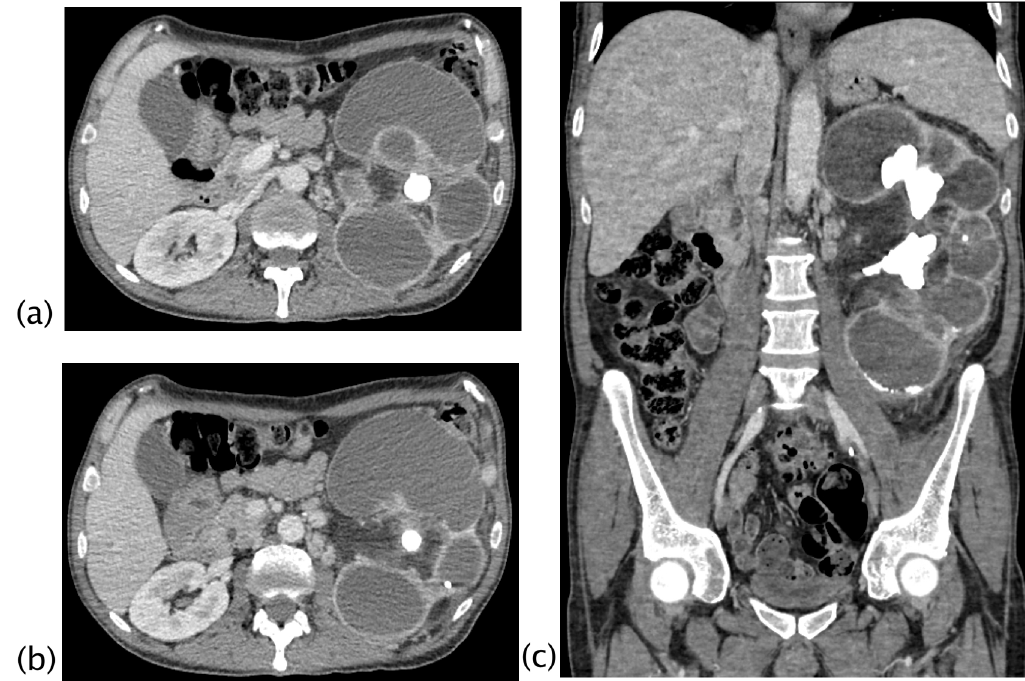
Figure 3. Xanthogranulomatous pyelonephritis Stage I—nephritic form. CT with contrast agent: axial ( a , b ) and coronal MPR reconstruction ( c ). The left kidney is increased in volume with a characteristic “contracted” appearance of the renal pelvis. The renal parenchyma is extremely thinned and characterized by the presence of multiple hypodense areas representing both intraparenchymal collections of pus and dilated calyces. The wall of the pyelocaliceal structures is thickened and hyperemic due to granulation tissue and parenchymal compression caused by abscess cavities. Staghorn lithiasis is present. Perirenal fat is thickened but no peri- or pararenal collections are present. No fistulas or abscesses are evident. The characteristic “bear paw sign” and contracted appearance of the pelvis allowed for the diagnosis of XGP, confirmed on histologic examination. The “bear paw sign” was appreciated on the CT scan in 66.67% of patients.